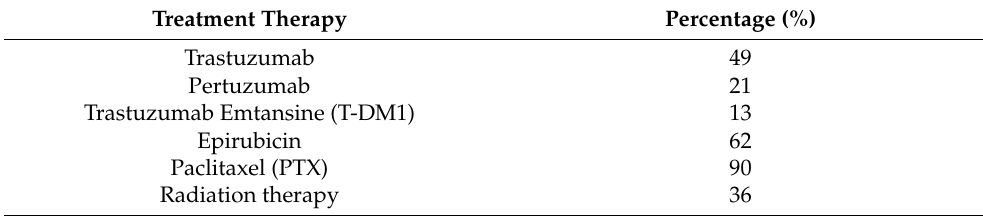
Table 1. Anti-cancer treatments used for patients.